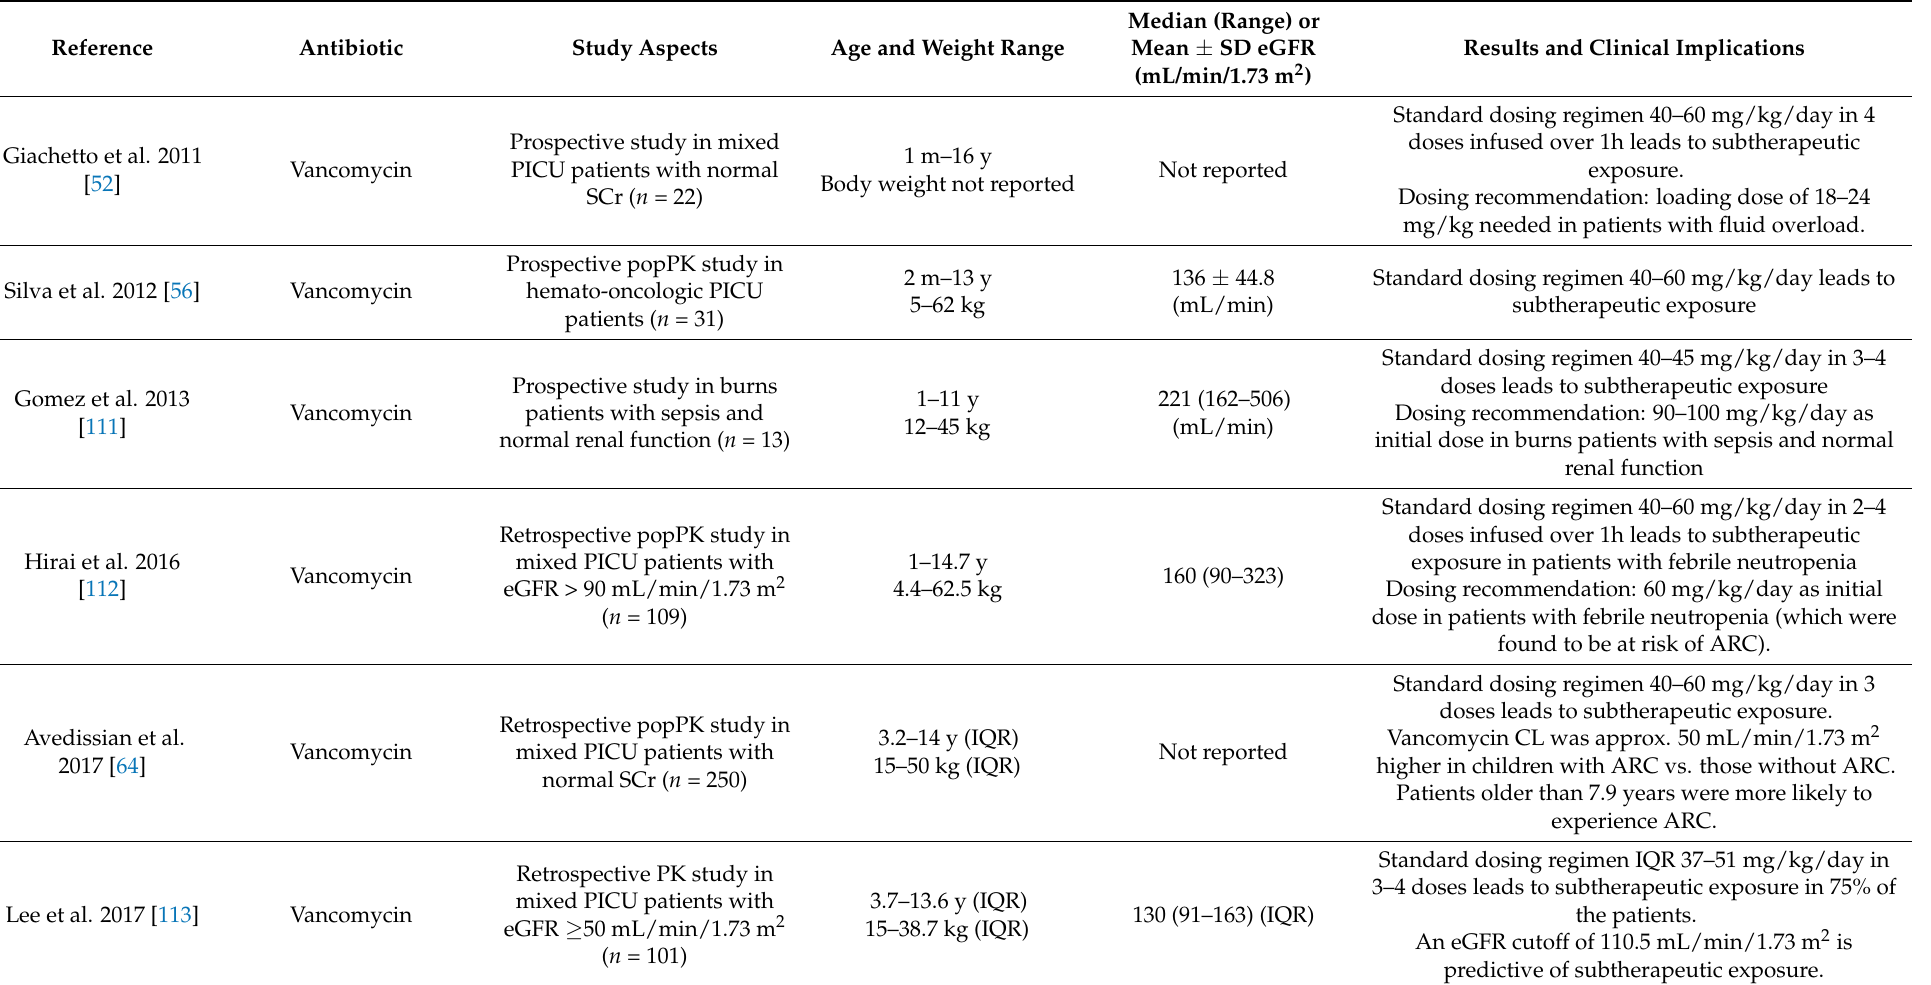
Table 4. Overview of all antibiotic PK studies performed in critically ill children and infants with augmented renal